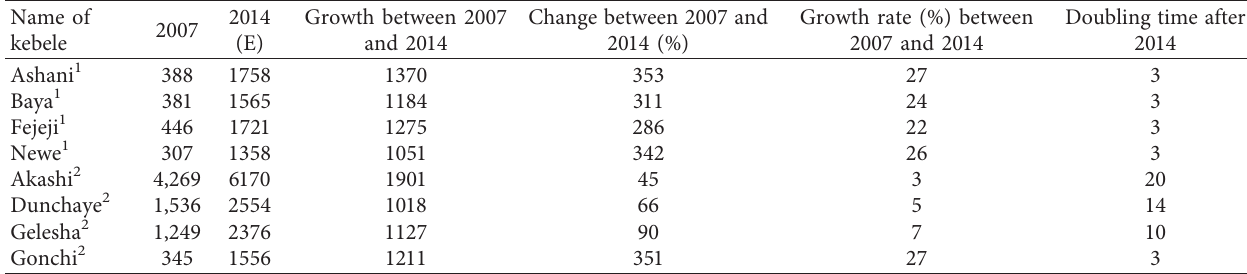
Table 13: Population number and growth rate in the sample kebeles of Majang Zone.